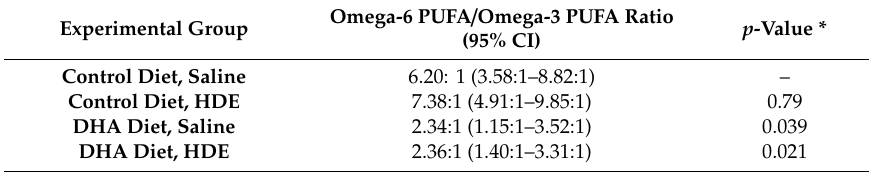
CI: Confidence interval; * p -values based on 2-way ANOVA with Tukey’s multiple comparisons post hoc analysis. Main e ff ect of diet, p <